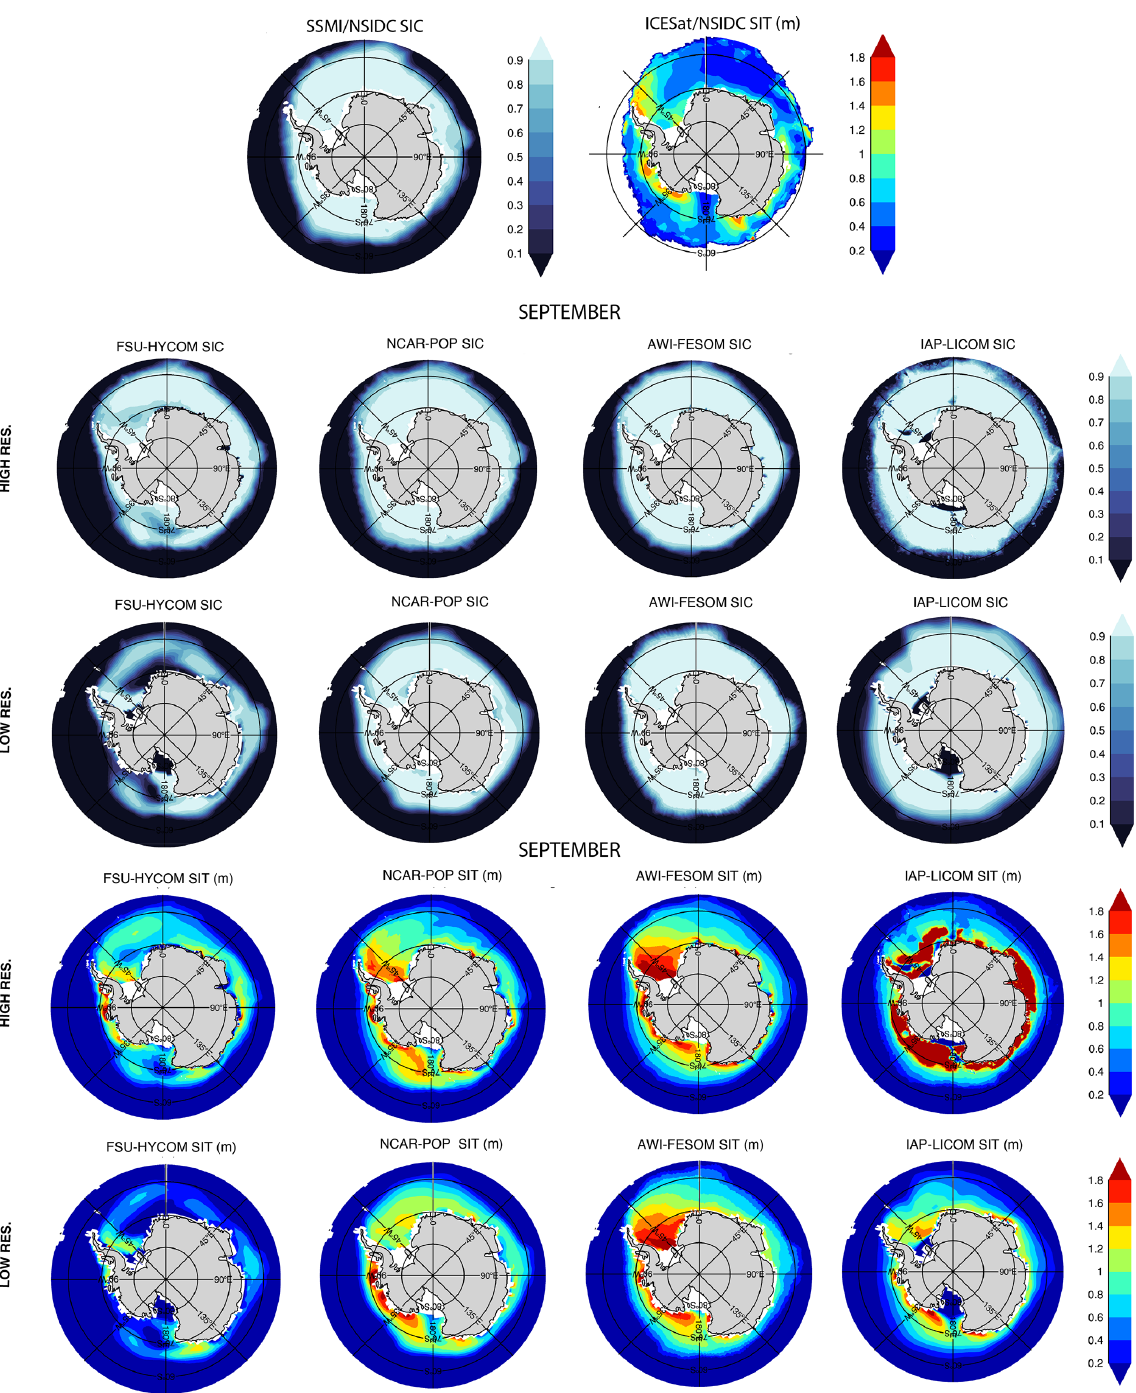
Figure 31. Southern Hemisphere winter mean (September) sea ice concentration (SIC) and thickness (SIT). Top panels: 1980–2018 SIC from passive microwave satellites and 2003–2007 SIT from ICESat. Lower panels: 1980–2018 modeled SIC and SIT.